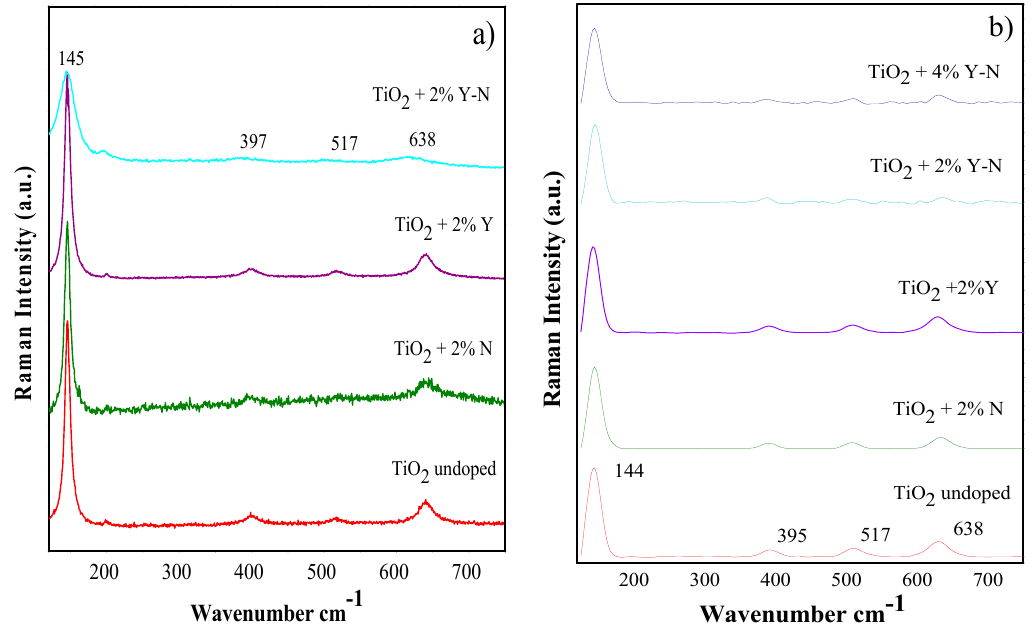
Figure 4. Raman spectra of undoped and 2% Y-N doped and codoped TiO 2 thin films ( a ) and powder ( b ) annealed at 400 °C.